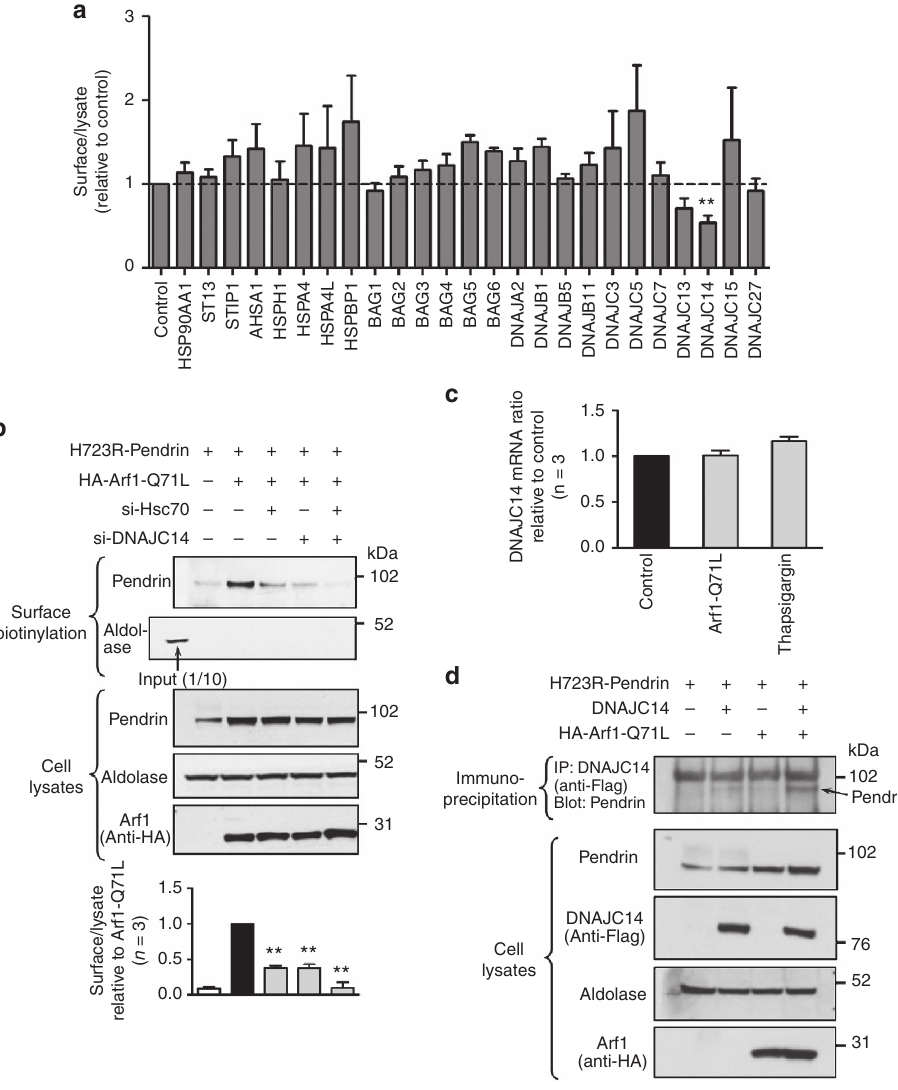
Figure 5 | DNAJC14 is necessary for unconventional surface trafficking of H723R-pendrin. ( a ) An siRNA screen was performed in PANC-1 cells transfected with plasmids encoding H723R-pendrin and Arf1-Q71L to identify J proteins or nucleotide exchange factors involved in the unconventional transport of H723-pendrin. Cells were treated with siRNA 24h before transfection with plasmids. Surface biotinylation assays were performed 24h after plasmid transfection, and the surface-to-lysate ratio was calculated by densitometry. A summary of multiple experiments is shown, and representative immunoblots are presented in Supplementary Fig. 4. ** P o 0.01 by one-way analysis of variance (ANOVA), n ¼ 4–7. ( b ) Treatment with siRNAs targeting DNAJC14 and Hsc70 cooperatively reduced the surface expression of unconventionally transported H723R-pendrin. ** P o 0.01 by one-way ANOVA, difference from Arf1-Q71L alone (lane 2), n ¼ 3. ( c ) Quantitative PCR analyses of DNAJC14 in PANC-1 cells. Arf1-Q71L or thapsigargin did not significantly alter the mRNA levels of DNAJC14. ( d ) Proteins samples from PANC-1 cells transfected with indicated plasmids were immunoprecipitated with anti-Flag (DNAJC14) and immunoblotted. Arf1-Q71L-mediated ER-to-Golgi blockade induced the association of DNAJC14 with H723R-pendrin. The data are representative of three independent experiments. Unprocessed original scans of western blots are shown in Supplementary Fig.